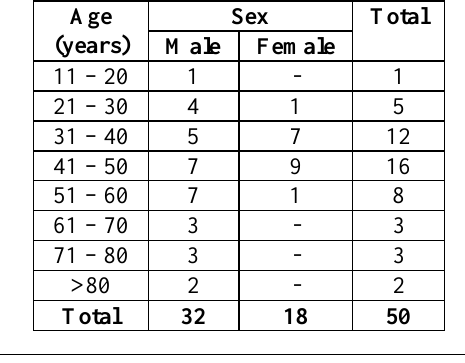
Table I : Sex-wise distribution of cases